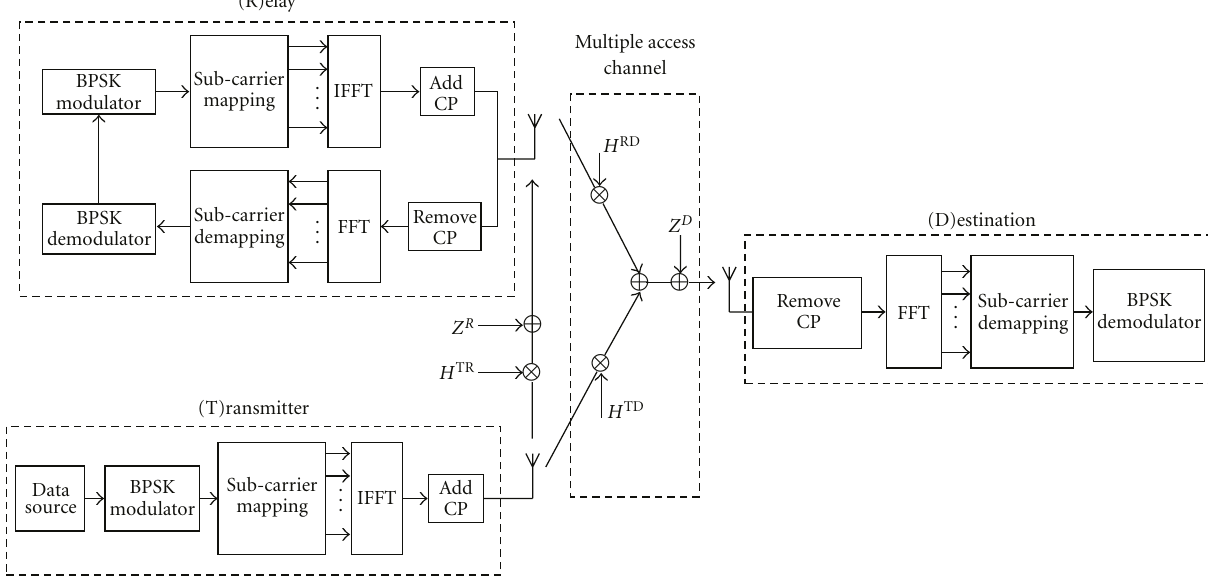
Figure 3: Block diagram of three cooperating nodes (transmitter-relay-destination) using orthogonal multicarrier